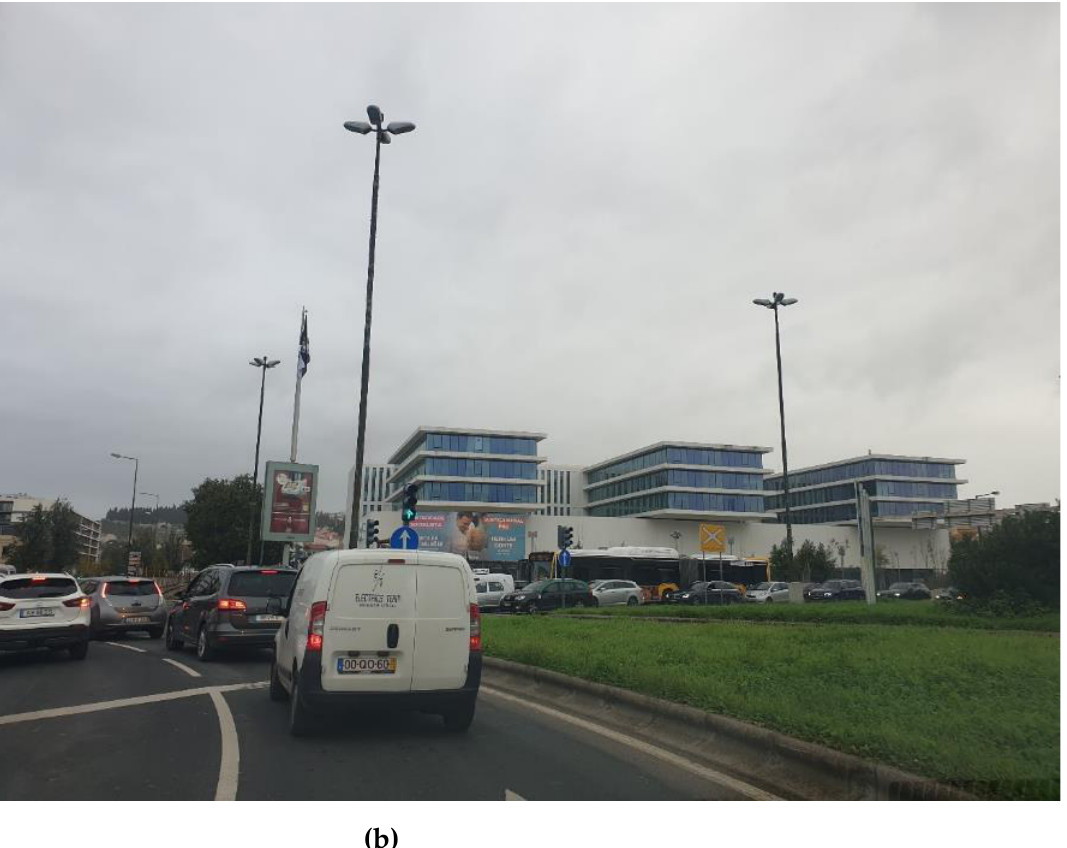
Figure 7. Alcântara EU Nascente — CUF Hospital Source: Sofia Morgado. ( a ) View from the 4th floor of CUF Hospital, November 2021; ( b ) view from the road junction, November 2022.